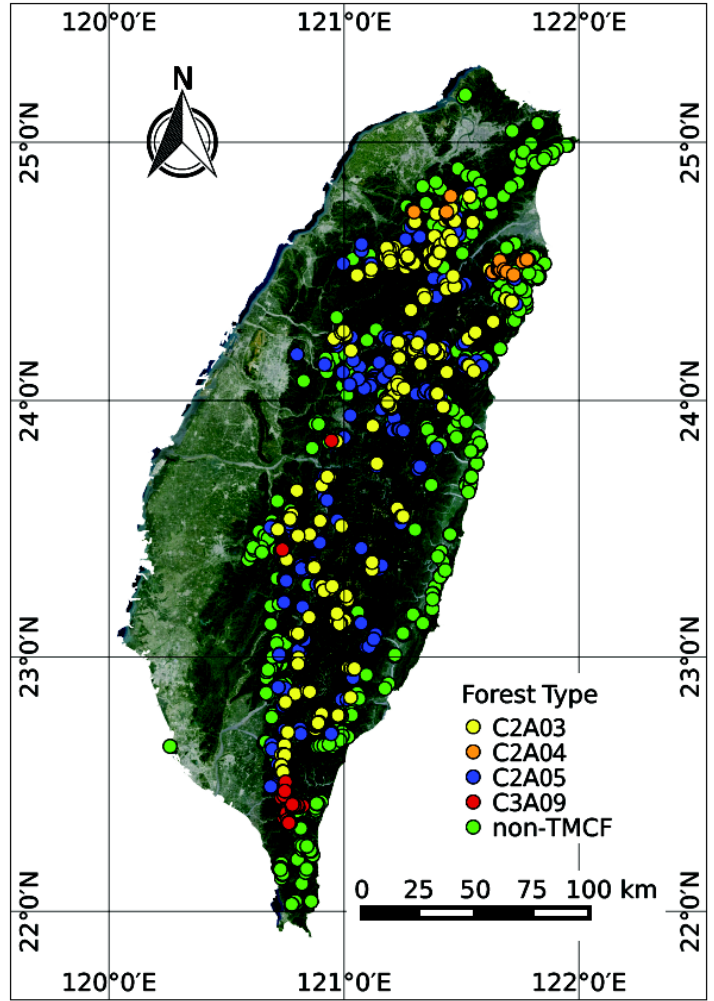
Figure 2. Spatial distribution of all 1603 TMCF and non-TMCF plots in Taiwan considered in this study. A Landsat 8 image is